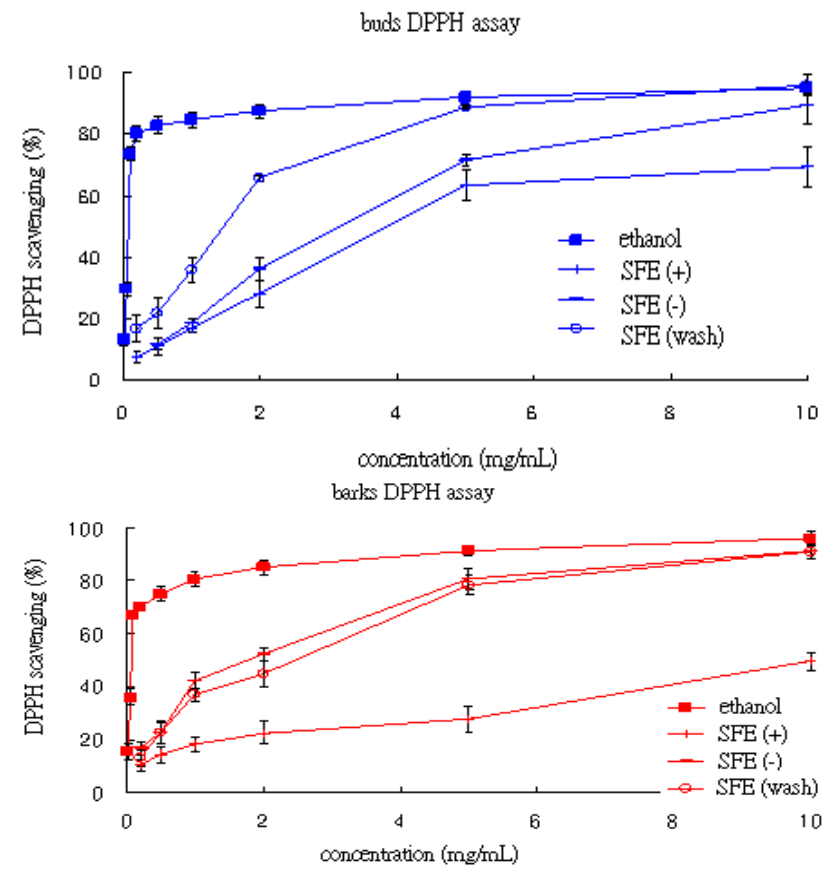
Figure 1. DPPH radical scavenging activity of the various extracts of C.